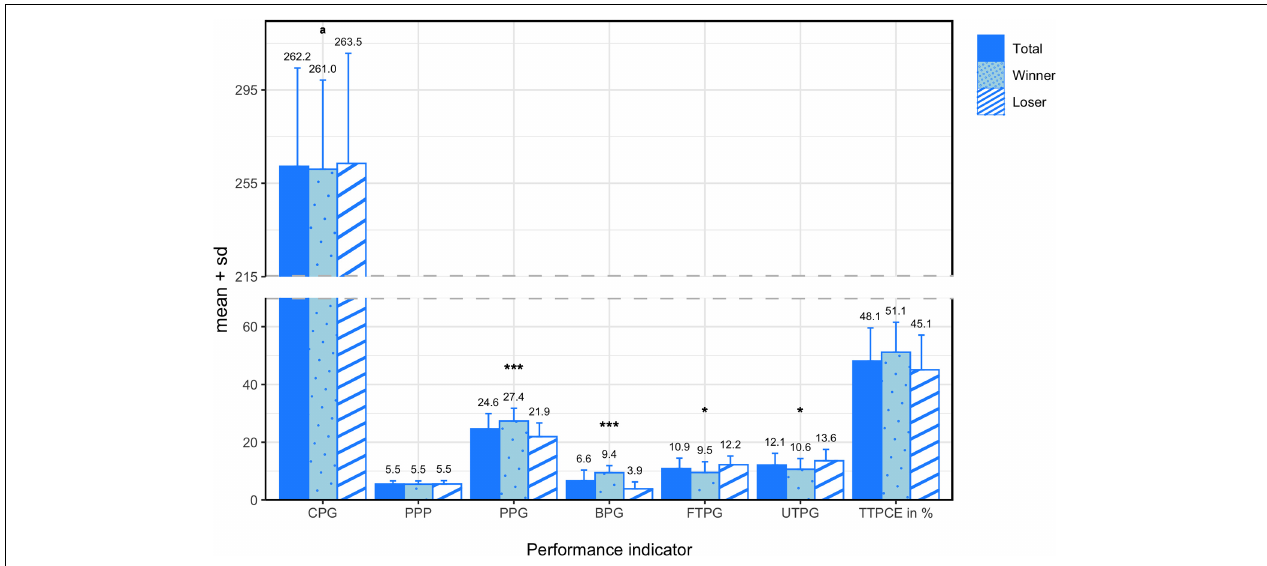
FIGURE 4 | Means and standard deviations of all performance indicators for all teams, winning teams, and losing teams. * denotes a significant difference between winning and losing teams at a significance level of 0.05 and *** at a significance level of 0.001. Variables compared using a non-parametric test are marked with an a .